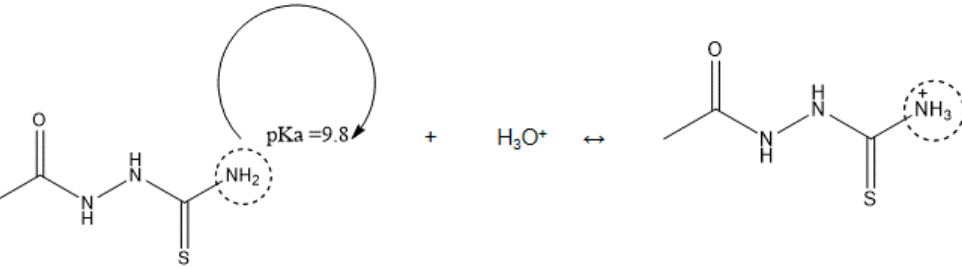
Figure 2. The protonation process of AST molecules in acidic solution.